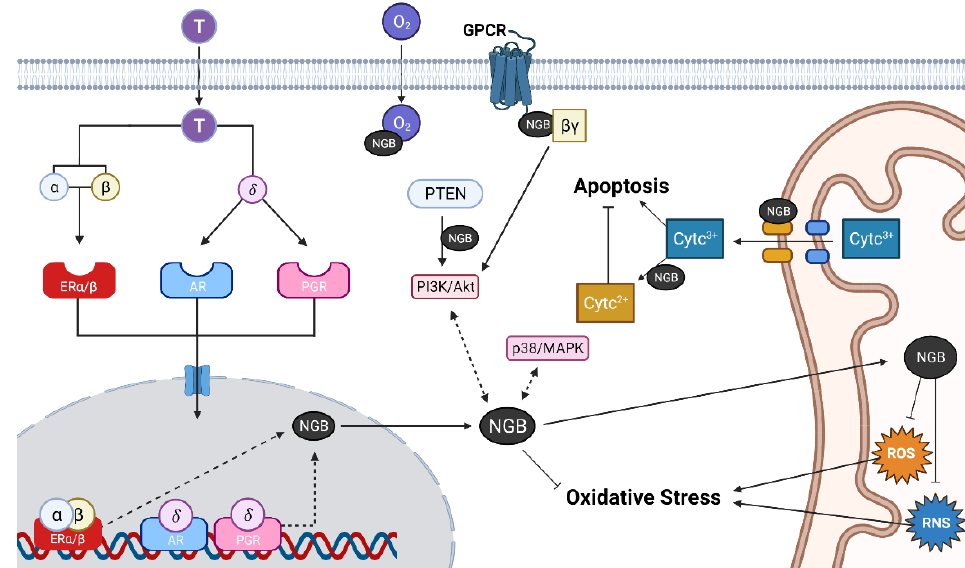
Figure 1. Transcriptional and post-translational regulation of neuroglobin (NGB) and biological functions. Abbreviations: T, tibolone; α, 3α - hydroxytibolone; β, 3β - hydroxytibolone; δ, δ4 -tibolone; AR, androgen receptor; ERα, estrogen receptor alpha; ERβ, estrogen receptor beta; PGR, progesterone receptor; cytc, cytochrome c; βγ , G protein beta and gamma subunits; PTEN, phosphatidylinositol 3,4,5-trisphosphate 3-phosphatase; ROS, reactive oxygen species; RNS, reactive nitrogen species.